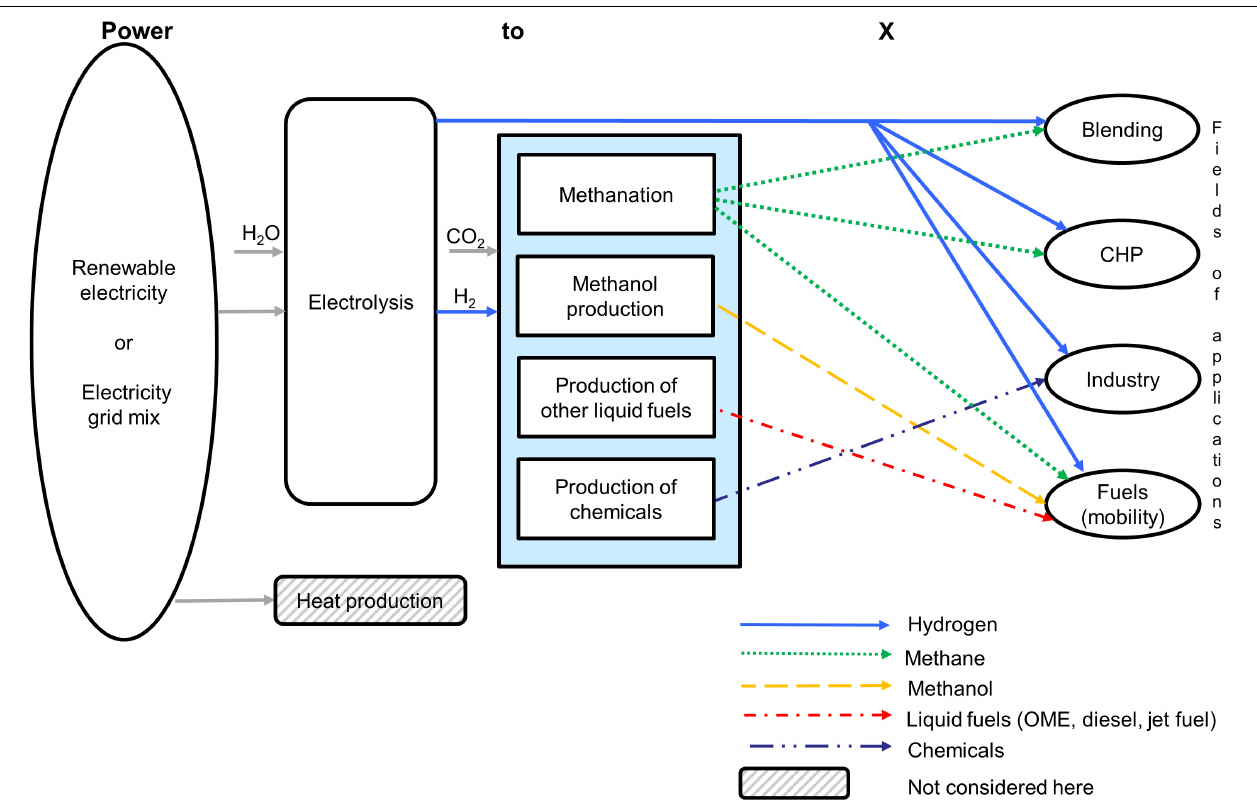
FIGURE 1 | Overview of Power-to-X process chains based on hydrogen. CO 2 , carbon dioxide; H 2 , hydrogen; H 2 O, water; CHP, combined heat and power; OME, polyoxymethylene dimethyl